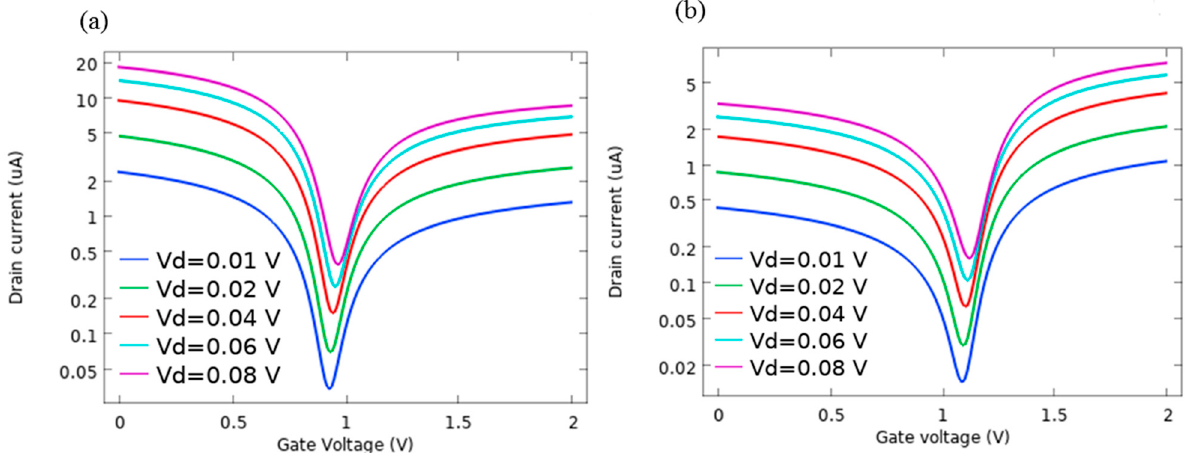
Figure 8. Carrier concentration in the graphene channel versus V g for ( a ) AlP-GFET, ( b ) Pd-GFET. This confirms the oc- currence of inversion of the device channel at V n .